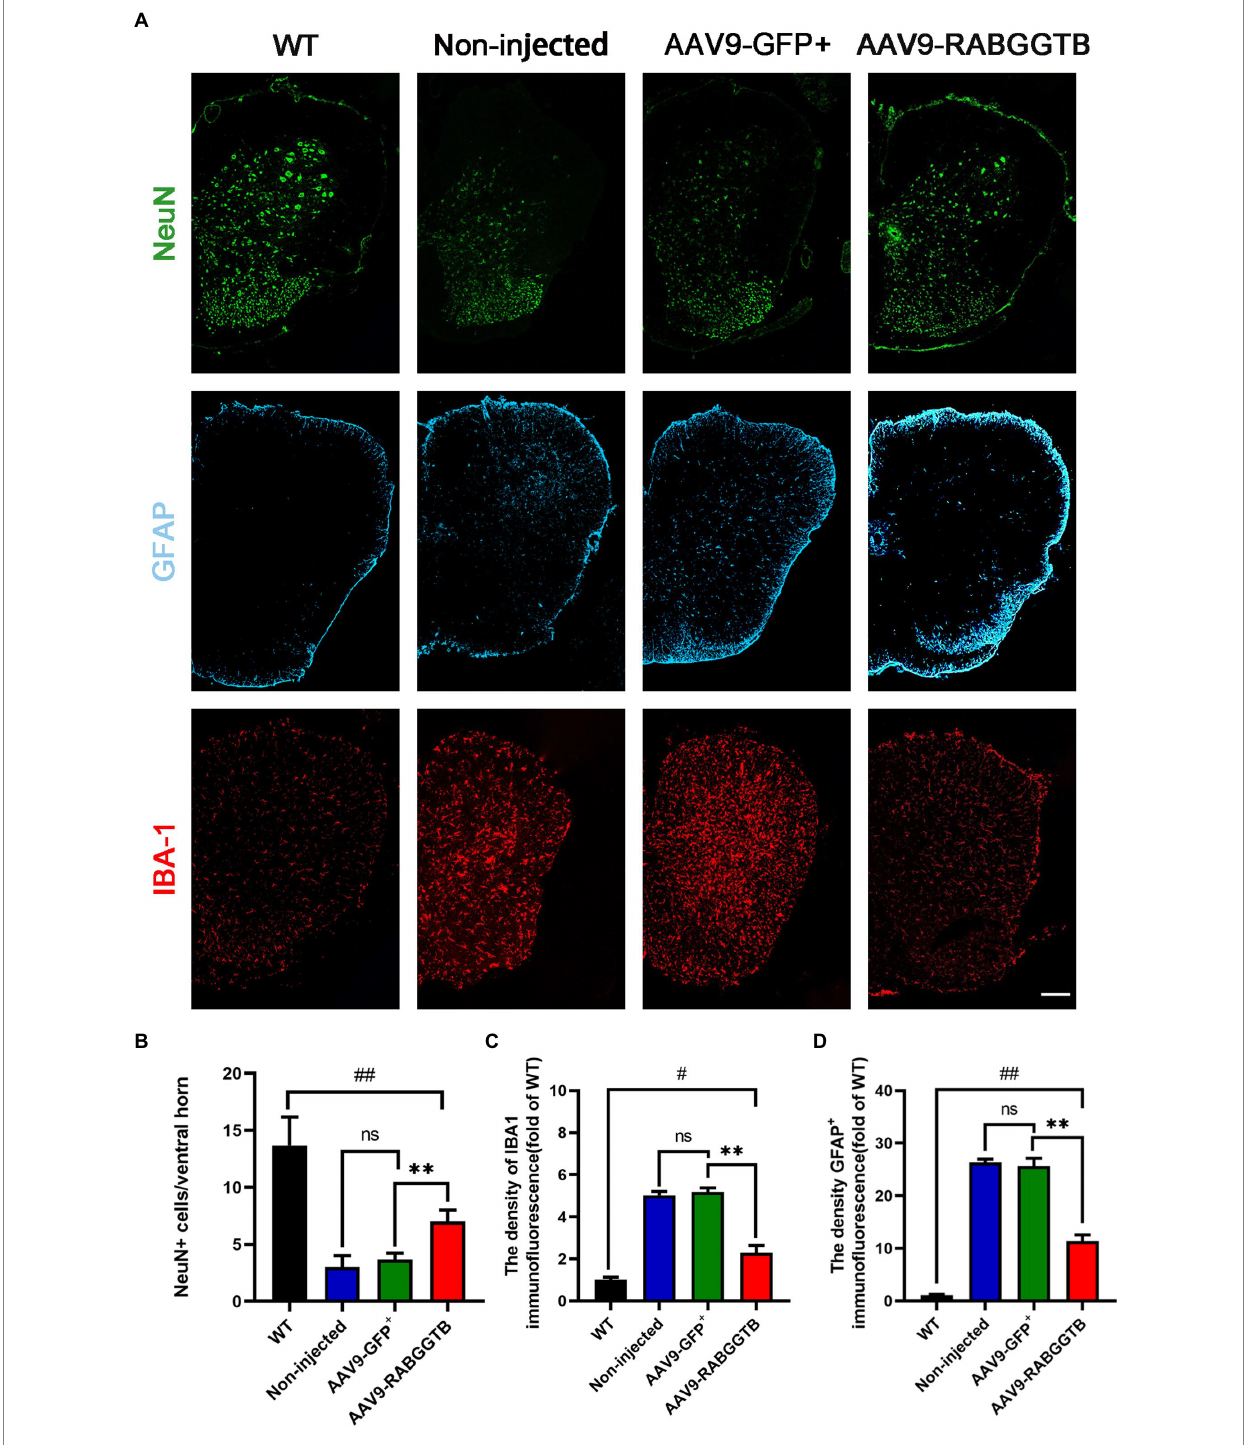
FIGURE 4 Expression of RabGGTB in the lumbar spinal cord protected motor neurons and had an effect on the overactivation of astrocytes and microglia in SOD1 G93A mice. (A) Immunofluorescence staining of Neun, GFAP, and Iba1 in the lumbar spinal cord at 120 days (scale bars, 150 μ M). (B) At day 120, Neun-positive motor neurons in the anterior horn of the spinal cord were counted in each group ( n = 3 mice per group). (C) Quantification the intensity of GFAP-positive cells in the lumbar spinal cord ( n = 3 mice per group). (D) Quantification of the intensity of IBA1-positive cells in the lumbar spinal cord. Data represent the mean ± SEM, n = 3 mice per group; p -values were determined using one-way ANOVA. Error bars denote the SEM. * p <0.05, ** p <0.01, *** p <0.001, # p <0.05, ## p <0.01, ### p <0.001. ns: no